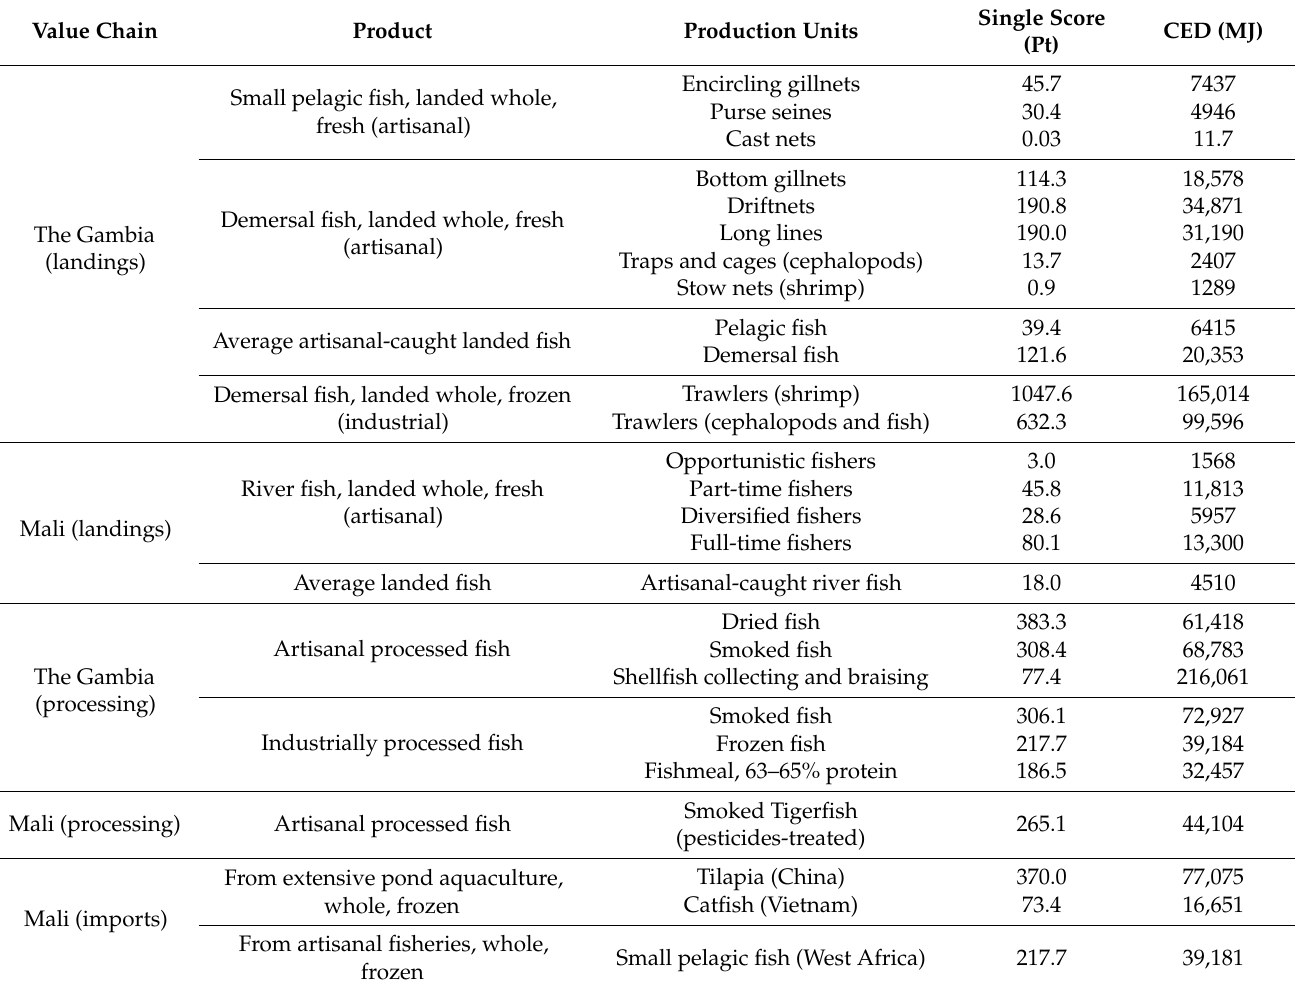
Table 3. Single score and cumulative energy demand (CED) of Gambian and Malian fish products per t of product. Value Chain Product Production